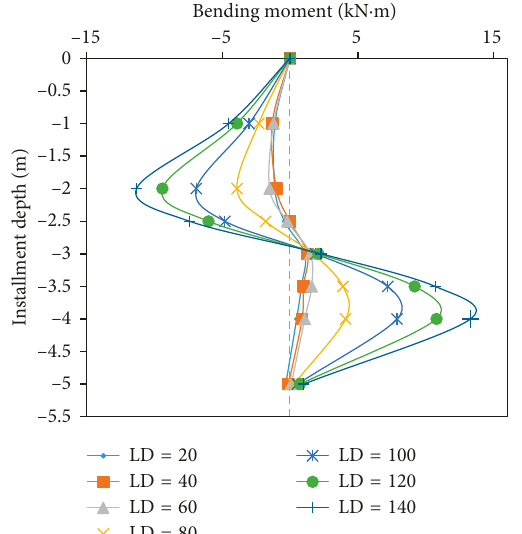
Figure 13: Variation of bending moment with installment depth for Test B (loading displacement short for